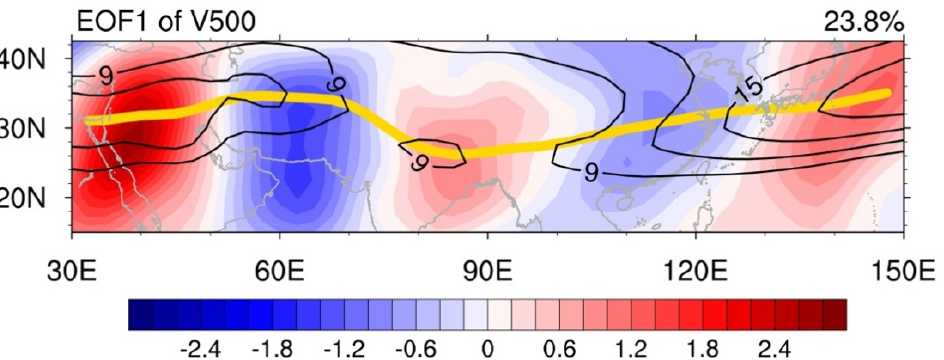
Figure 3. The leading EOF (EOF1) of the meridional wind anomalies (shading, unit: m s − 1 ) at 500 hPa over the domain 15 ◦ N–42.5 ◦ N, 30 ◦ E–150 ◦ E and climatological mean zonal wind (contour, contour interval (CI) = 3 m s − 1 )) at 500 hPa in May during 1979–2018. Only the climatological zonal winds speed ≥ 9 m s − 1 are displayed. The thick yellow curve delineates the climatological jet axis.